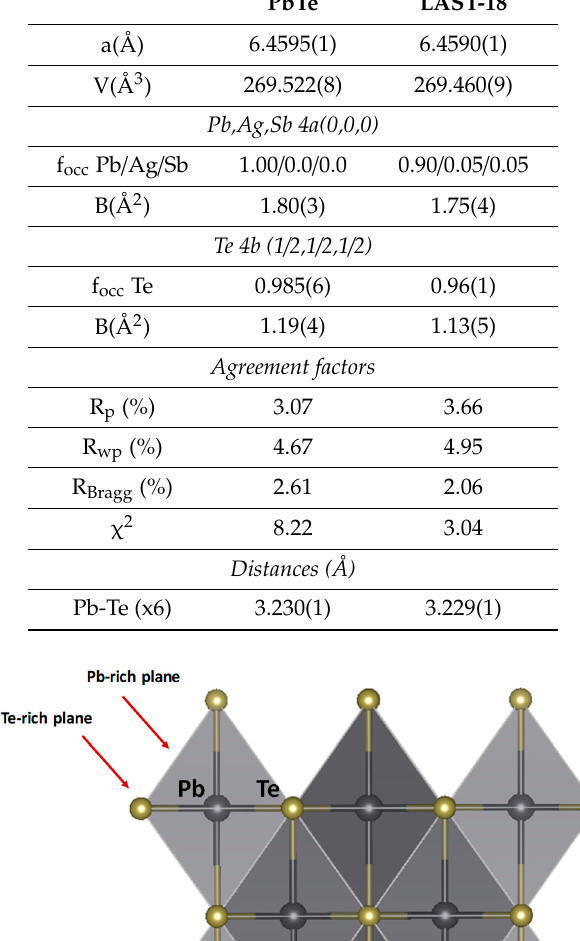
Table 1. Structural parameters of pristine PbTe and LAST-18 (AgPb 18 SbTe 20 ) from NPD data at 298 K, with λ = 1.594 Å.